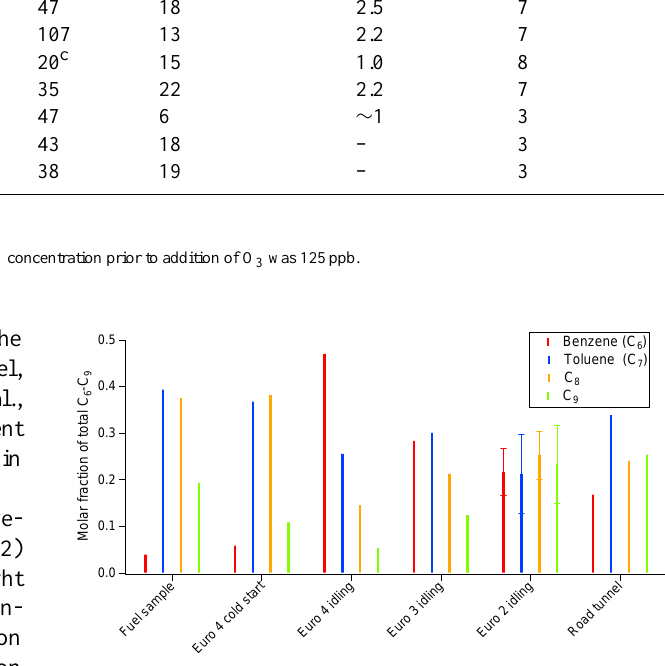
Fig. 2. The molar fraction of C 6 –C 9 light aromatics (GC-MS) in the exhaust, a sample of the gasoline fuel used in the measurement campaign and VOC measurements in a road tunnel (Legreid et al., 2007). The whiskers indicate ± 1 standard deviation ( σ ) of repeated measurements. Legreid et al. (2007) only measured 1,2,4-TMB; the total C 9 concentration is estimated from that number and the frac- tion of 1,2,4-TMB of total C 9 in our exhaust measurements.